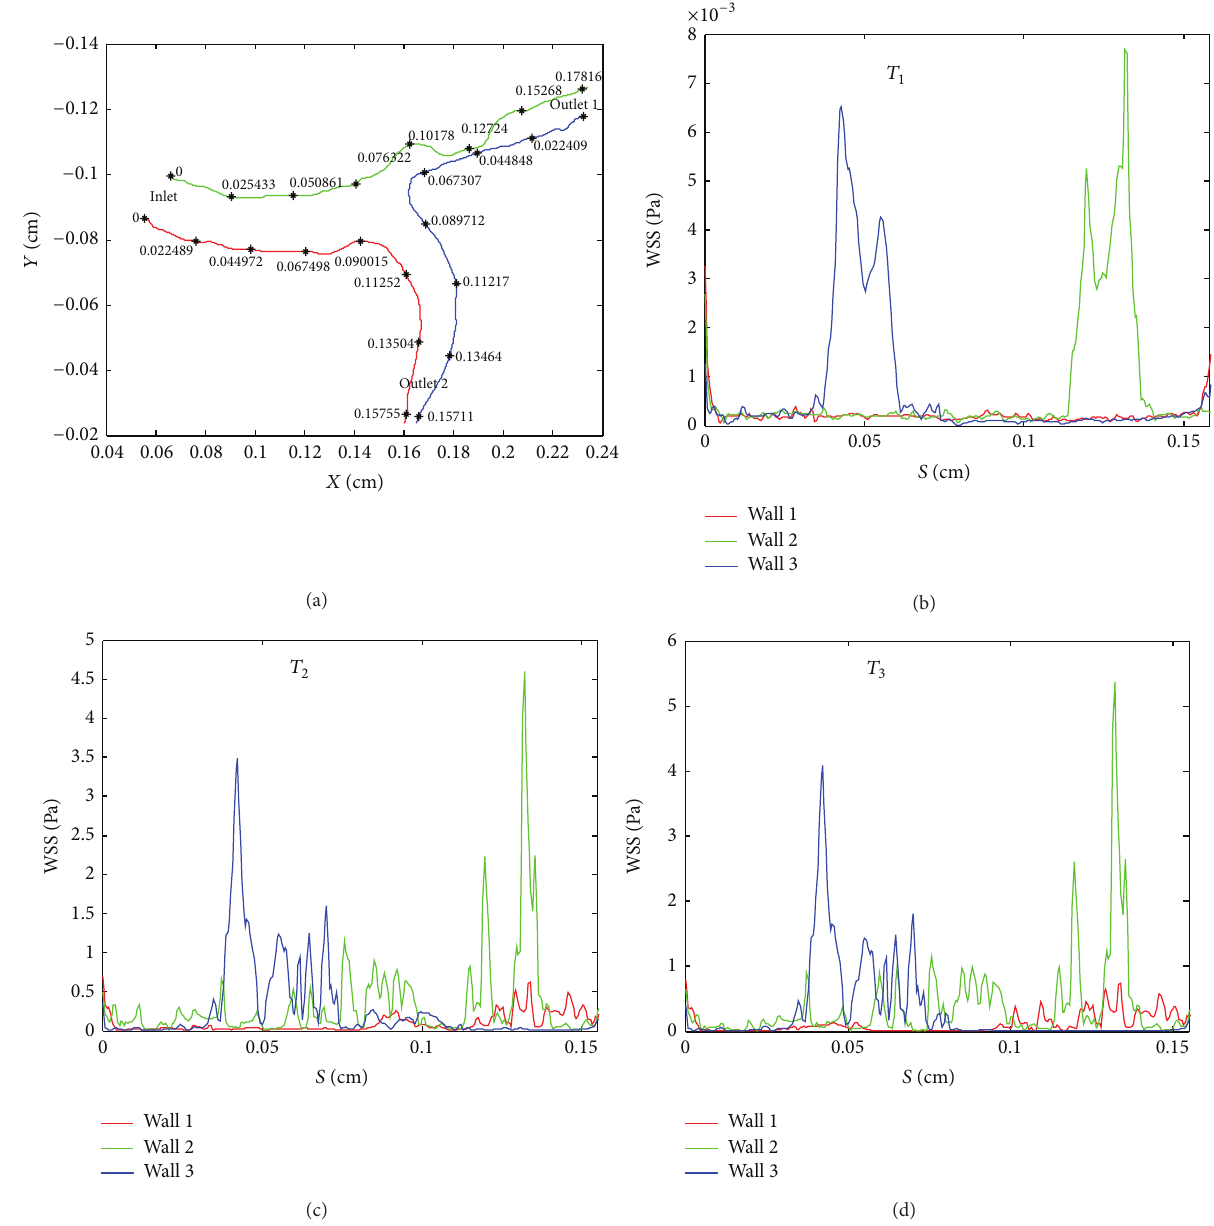
Figure 2: (a) Boundary plots of the coronary arterial walls 1, 2, and 3 shown in red, green, and blue, respectively. (b)–(d) WSS distribution along coronary walls at time 𝑇 1 , 𝑇 2 , and 𝑇 3 ,